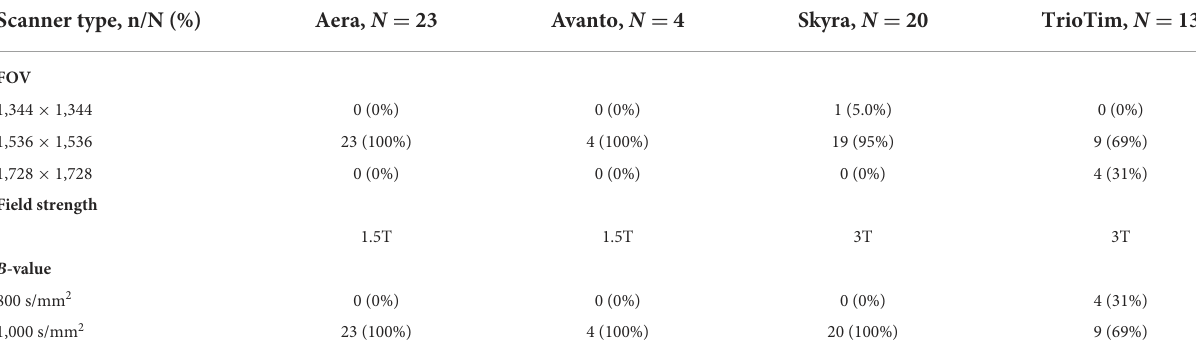
TABLE 2 MRI scan parameters used in this